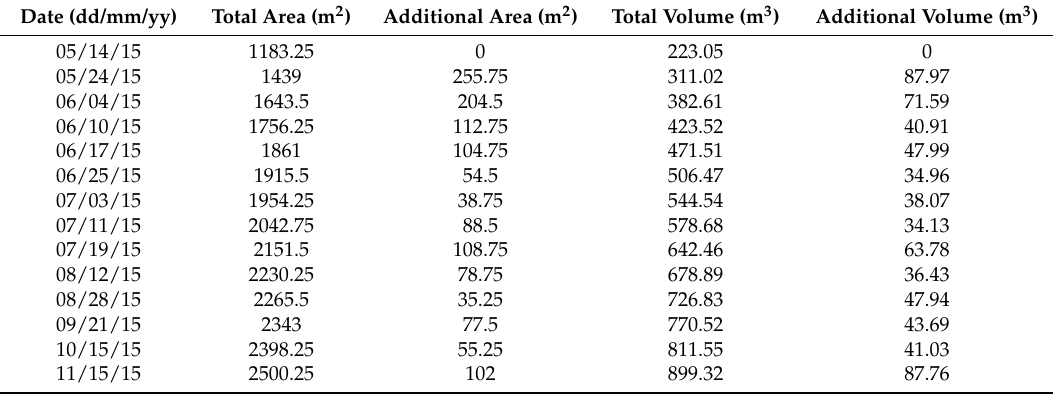
Table A1. Phragmites australis growth from terrestrial lidar acquisitions throughout 2015. Volumes rounded to two decimal places.